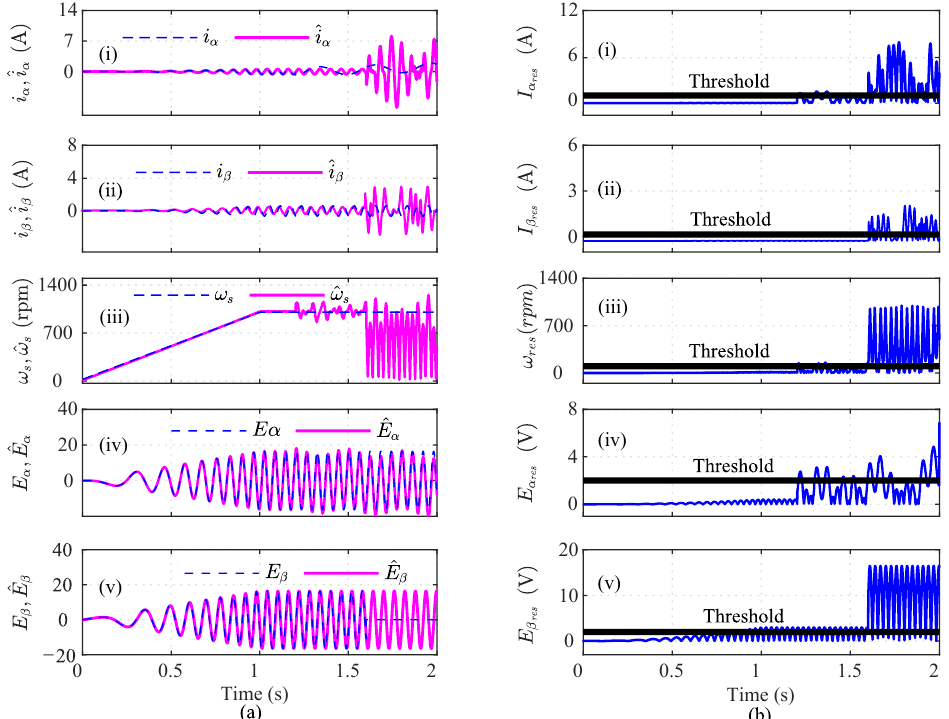
Figure 6. Analysis of residuals for V β using index-based method ((i) MRI, (ii) MAI, (iii) MVI, (iv) MEI, (v) DBI 1 and (vi) DBI 2 ) for the I α and I β fault at t = 0.739 s and t = 1.52 s.